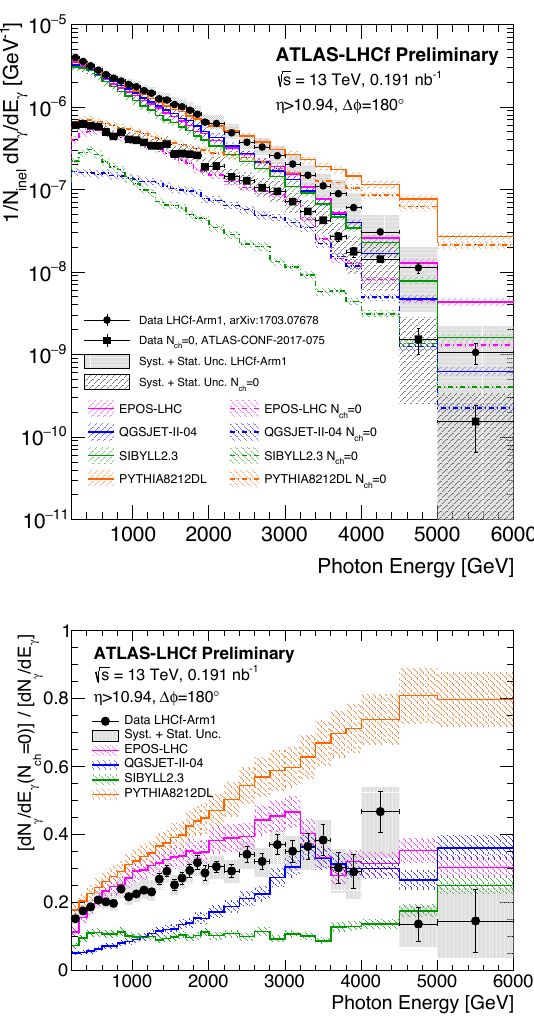
Figure 3. Forward photon energy spectrum measured by the η > 10.94 (top pad). Filled circles LHCf-Arm1 detector at | | show the inclusive-photon spectrum measured in Ref. [6]. Filled squares indicate the spectrum for N ch = 0 events [7], where no ex- η < 2.5 are present. tra charged particles with p T > 100 MeV and | | Colored lines indicate model predictions with (dashed lines) and without (solid lines) the N ch = 0 requirement. Ratios of N ch = 0 events to the inclusive events as a function of photon energy are shown in the bottom